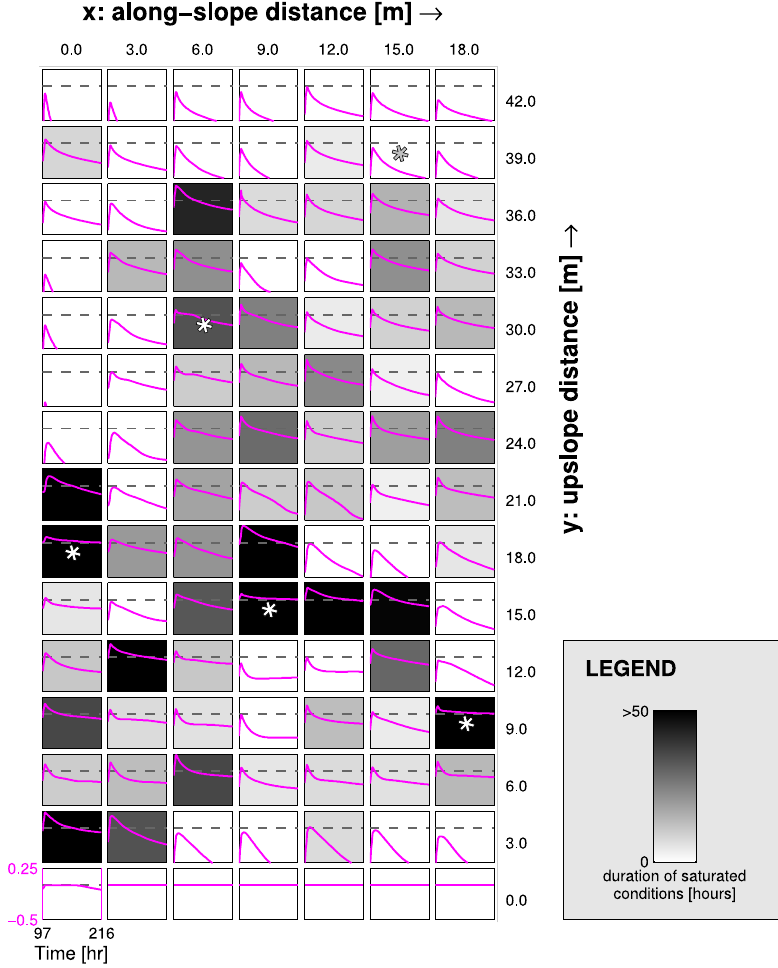
Fig. 3. Artificial measurements: simulated traces of pressure head in space and time. For each node at the soil–bedrock interface, the figure contains a subplot showing a time series of the pressure head (magenta line) for t = 97–216h. Horizontal dashed lines represent zero pressure head. Each subplot’s axes have been clipped vertically to [ − 0.5,0.25] in order to better show the pressure head dynamics during relatively wet conditions. To further ease interpretation, each subplot was assigned a background color depending on how long saturated conditions lasted at a given location. The locations of sink hotspots are indicated with asterisks.